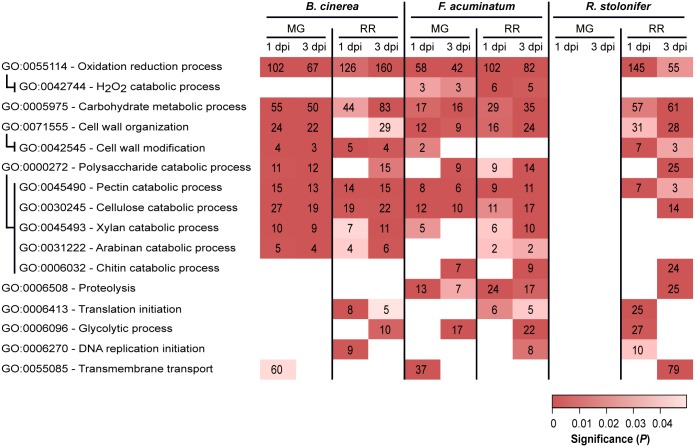
Subset of overrepresented Gene Ontology (GO) terms associated with pathogenicity and fungal growth among upregulated genes in Botrytis cinerea, Fusarium acuminatum and Rhizopus stolonifer inoculated samples. Indented GO terms are nested in the GO term above. Box color indicates the significance of enrichment, and values in the boxes indicate the number of upregulated genes in this comparison that share the indicated annotation. dpi, days post-inoculation; MG, mature green; RR, red ripe. Supplementary Table S8 includes the complete list of overrepresented GO terms.